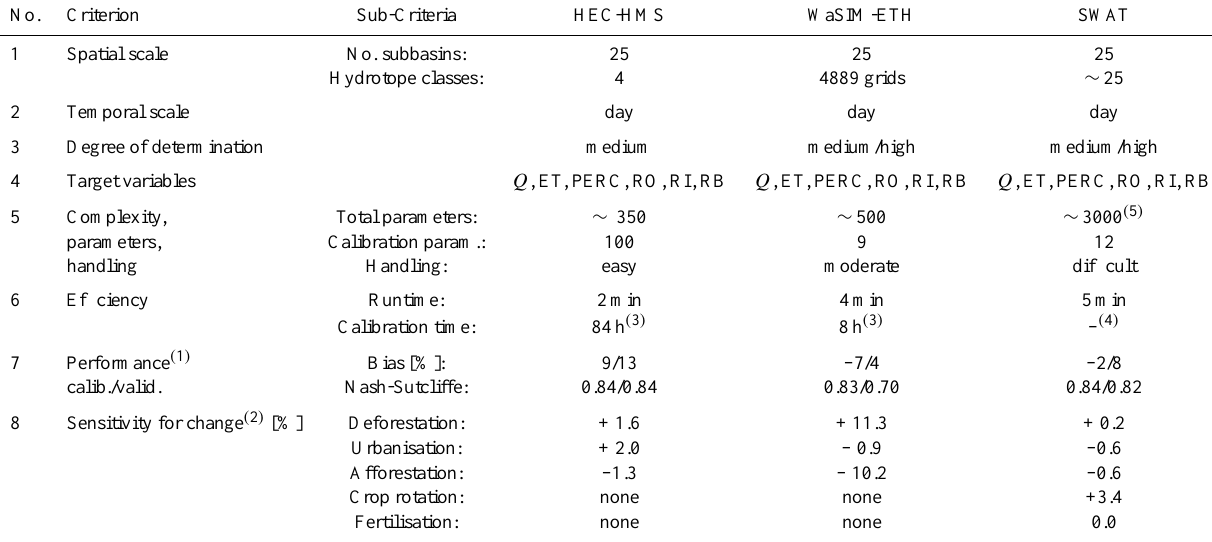
Table 2. Results for the comparison of the models HEC-HMS, WaSIM-ETH and SWAT. No. Criterion Spatial scale Temporal scale